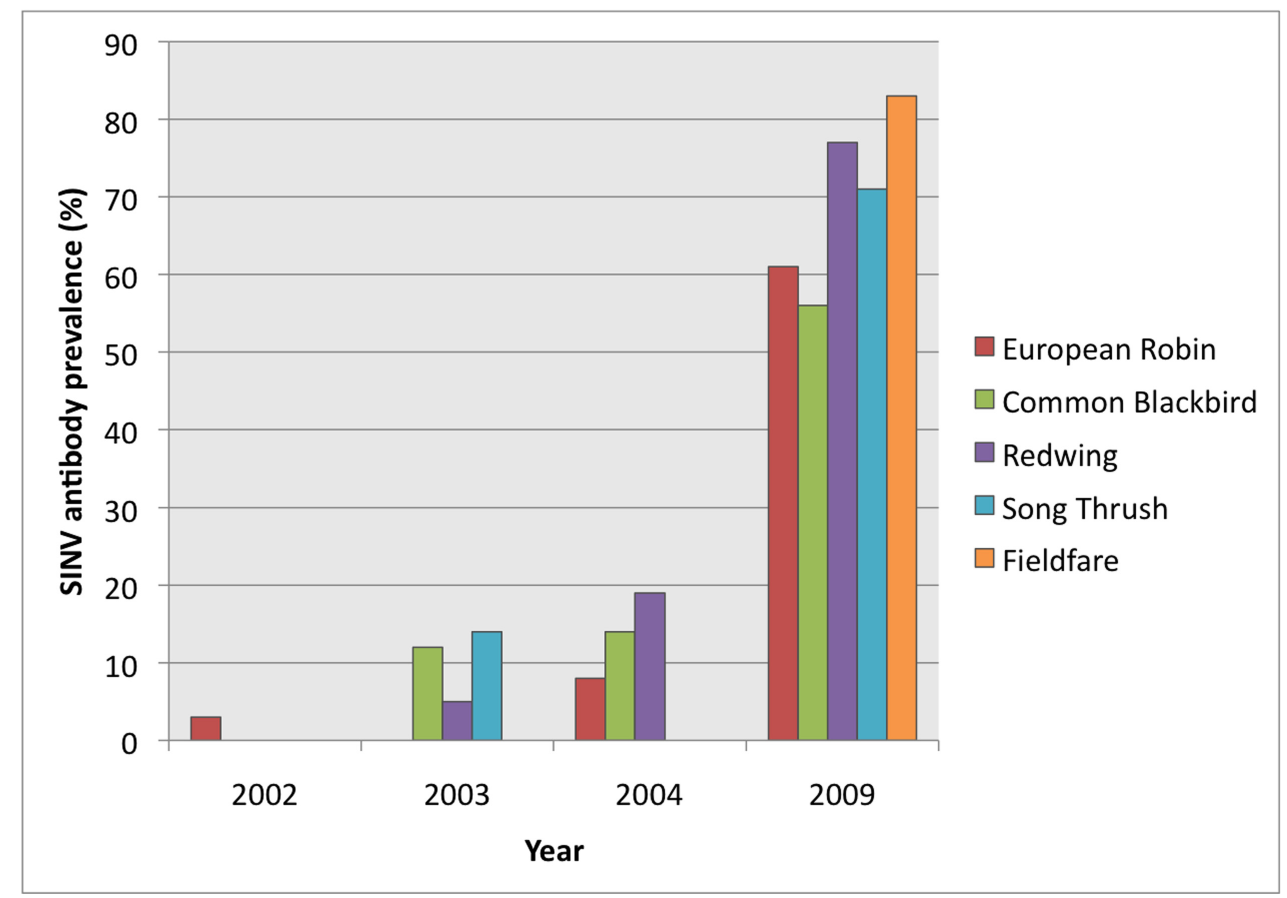
Fig 1. Sindbis virus neutralizing antibody prevalence in species of thrushes in the River Dalälven floodplains,